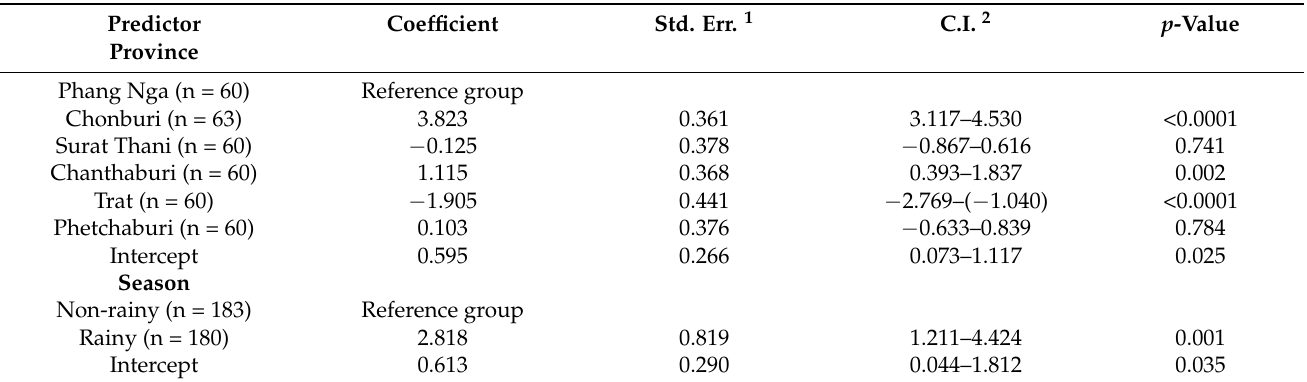
Table 6. Negative binomial regression model of the E. coli concentrations as a function of province and season in coastal water samples (n = 363) from oyster production regions in Thailand.